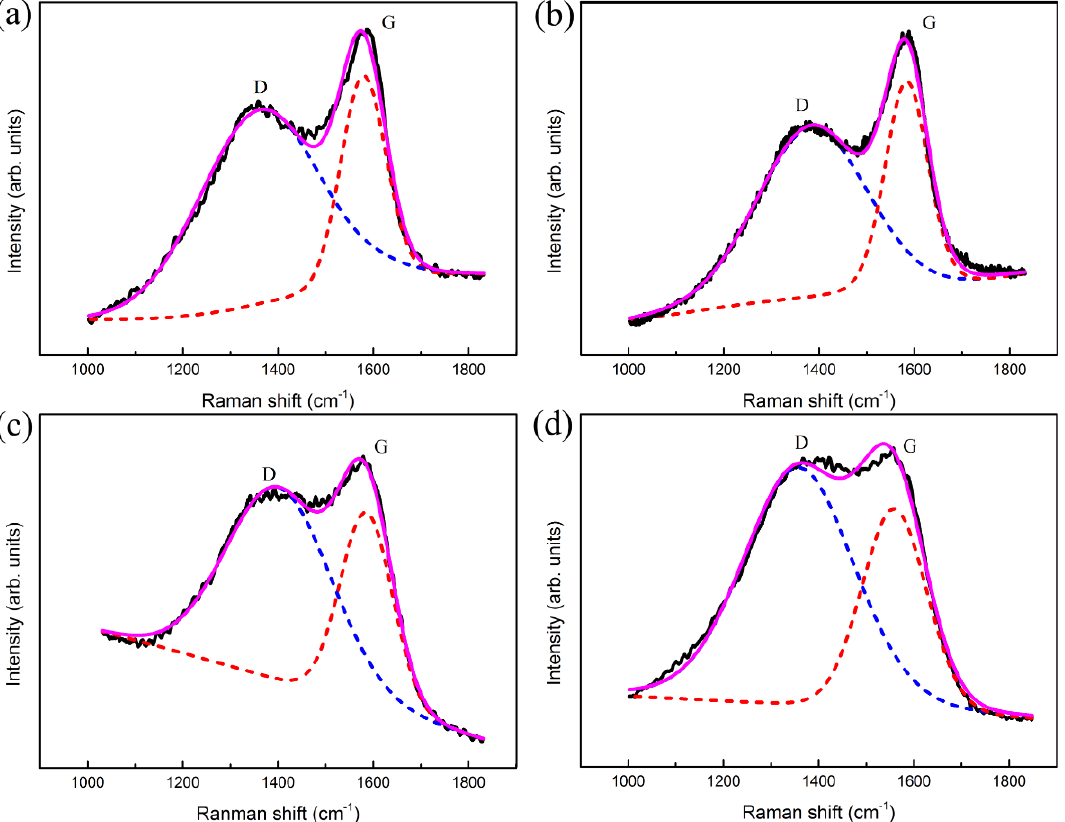
Figure 5. Deconvoluted Raman spectra of Ti-DLC coatings with Ti transition layer thickness ( t 0 ): ( a ) 0 μm, ( b ) 0.5 μm, ( c ) 1.1 μm and ( d ) 2.8 μm.